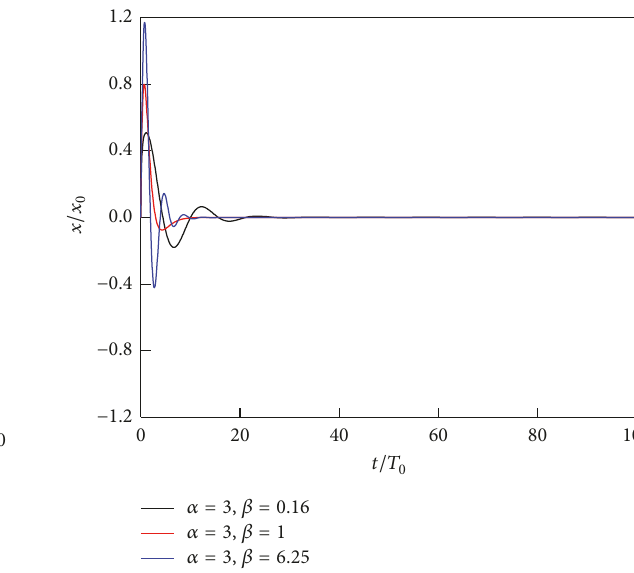
Figure 35: Response in the time domain ( 𝛼 = 3, 𝛽 = 0.16, 1,6.25 ).